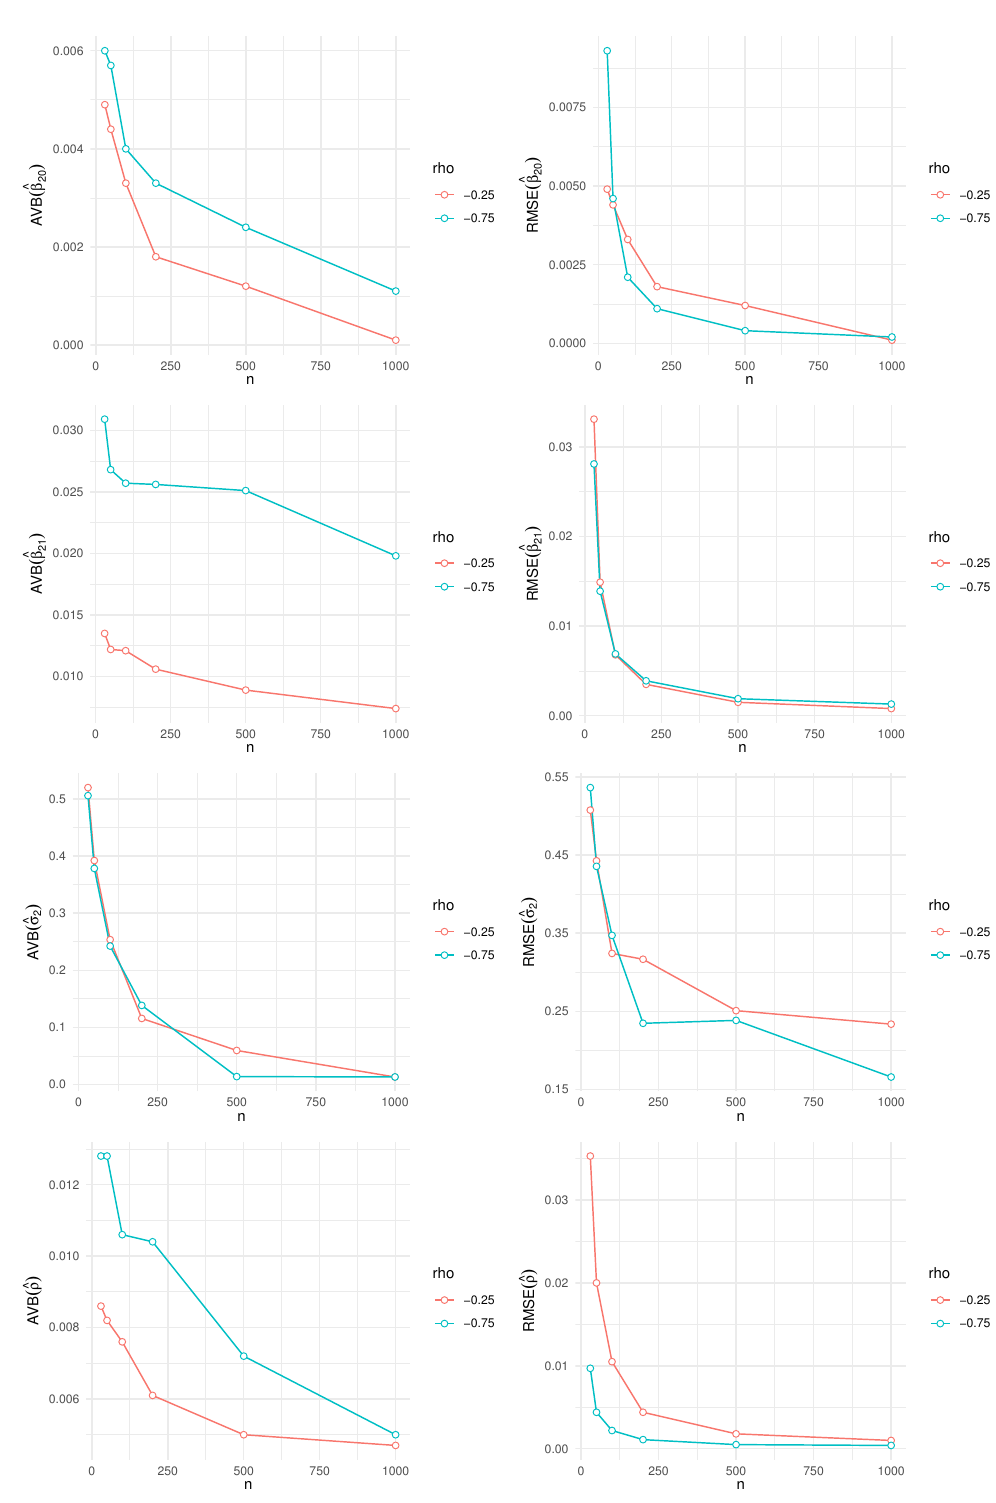
Figure 2. Asymptotic behavior of the MLE for the BVSHN regression model for scenario